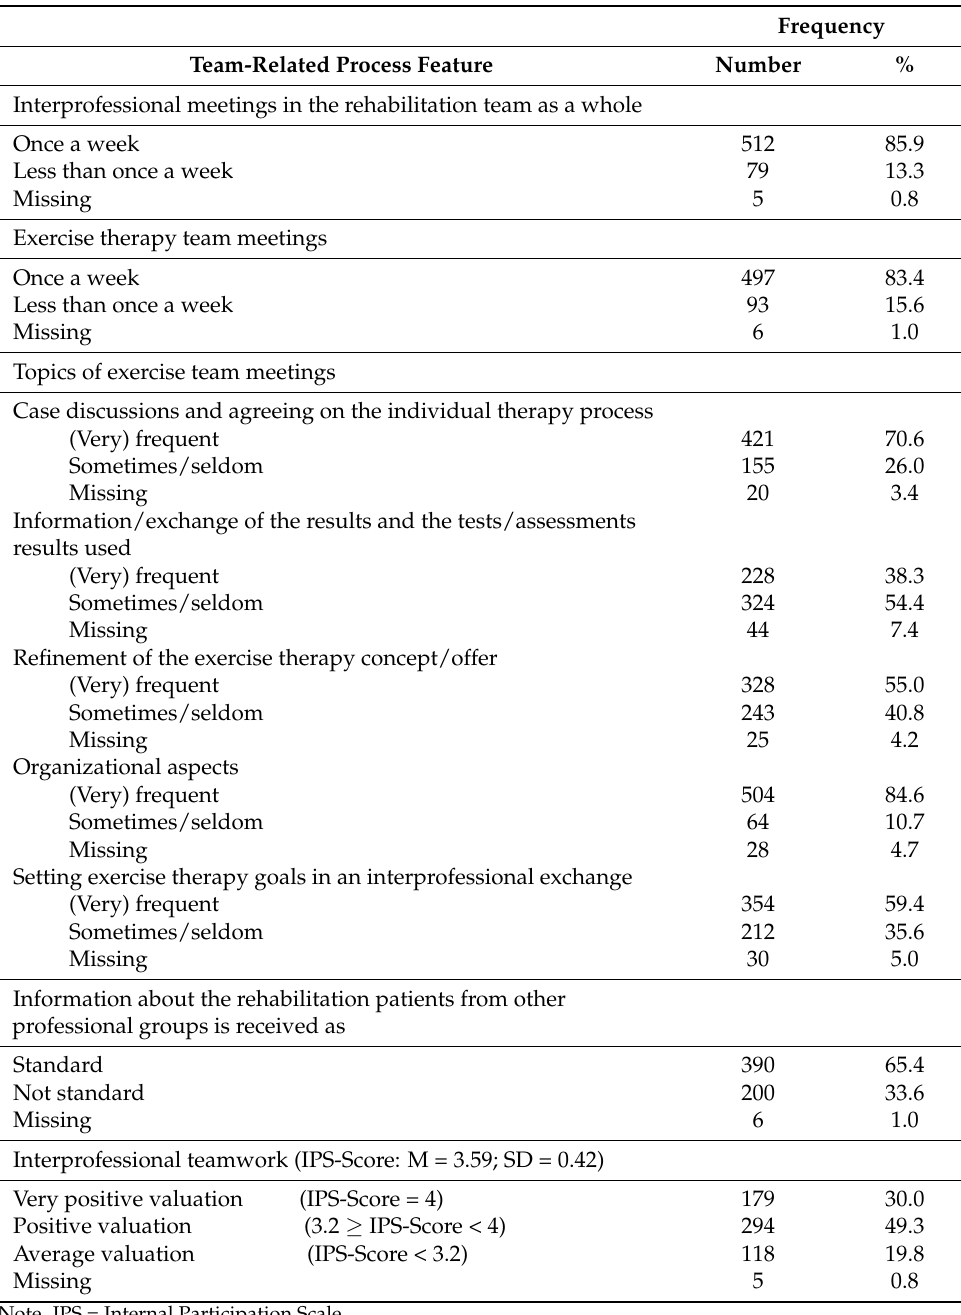
Table 2. Descriptive parameters of team-related process features of the quantitative part of the study for departments that had at least two full-time equivalents in total (n =